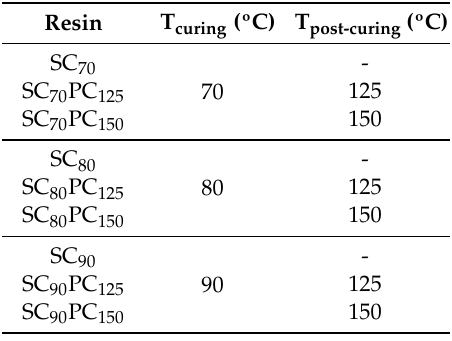
Table 1. Composition and labelling of the partially bio-based epoxy resins according to the selected curing and post-curing temperatures. The standard curing (SC) and the post-curing (PC) treatments were applied for 1 h and 30 min,